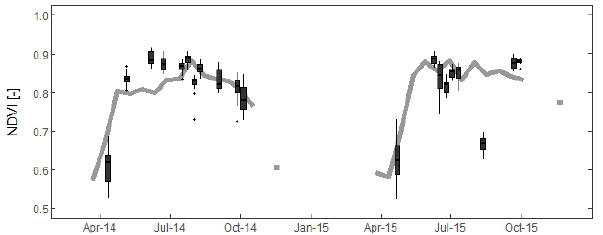
Figure 5. Observed NDVI dynamics during the growing seasons of 2014 and 2015. The grey line and dots represent the mean NDVI over the forested clusters derived from the MOD13Q1 product of MODIS. It provides a better overview of the seasonal course. The 20 boxplots (in black) show the variability in Landsat-derived NDVI over the studied clusters for each studied